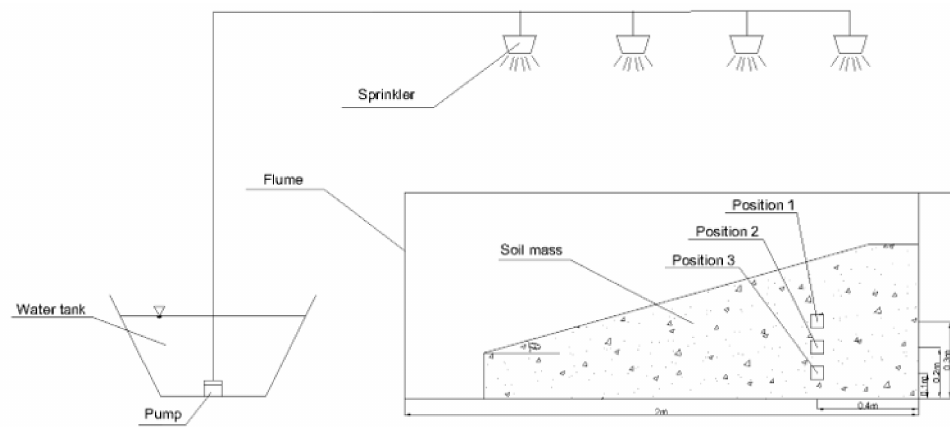
Figure 1. Sketch of experimental setup.